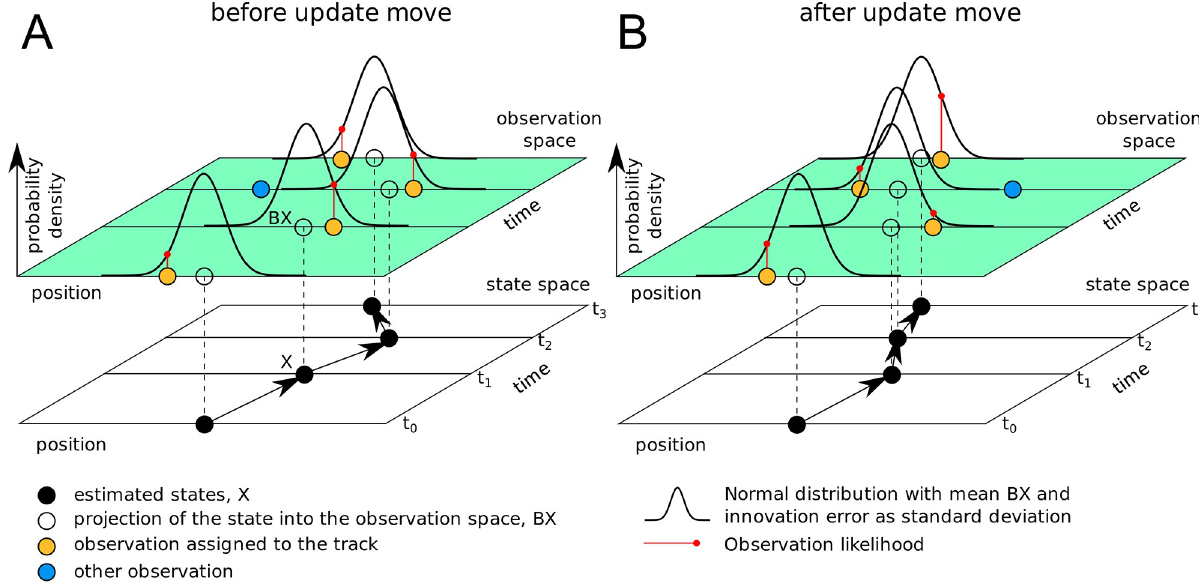
Fig 2. Principle of the observation likelihood calculation. The partition sampler has assigned the observations (yellow) to a track. From those observations, the Kalman filter estimates the most likely states (black) and the state estimation errors (not shown) given the model of particle motion. Under this fitted model, each observation assigned to the tracks has a specific likelihood, which is evaluated from a normal distribution that is centred in the projection of the state into the observation space and whose standard deviation is a combination of the observation error and the state estimation error. When the partition sampler reassigns an observation at time t 2 of the track by executing an update move, the fresh application of the Kalman filter results in new estimates for all states. That leads in turn to different observation likelihoods even for those observations whose assignment has not